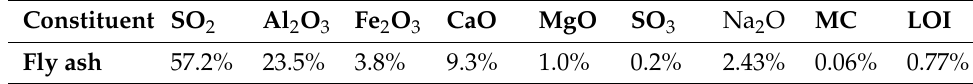
Table 3. Fly ash chemical composition.